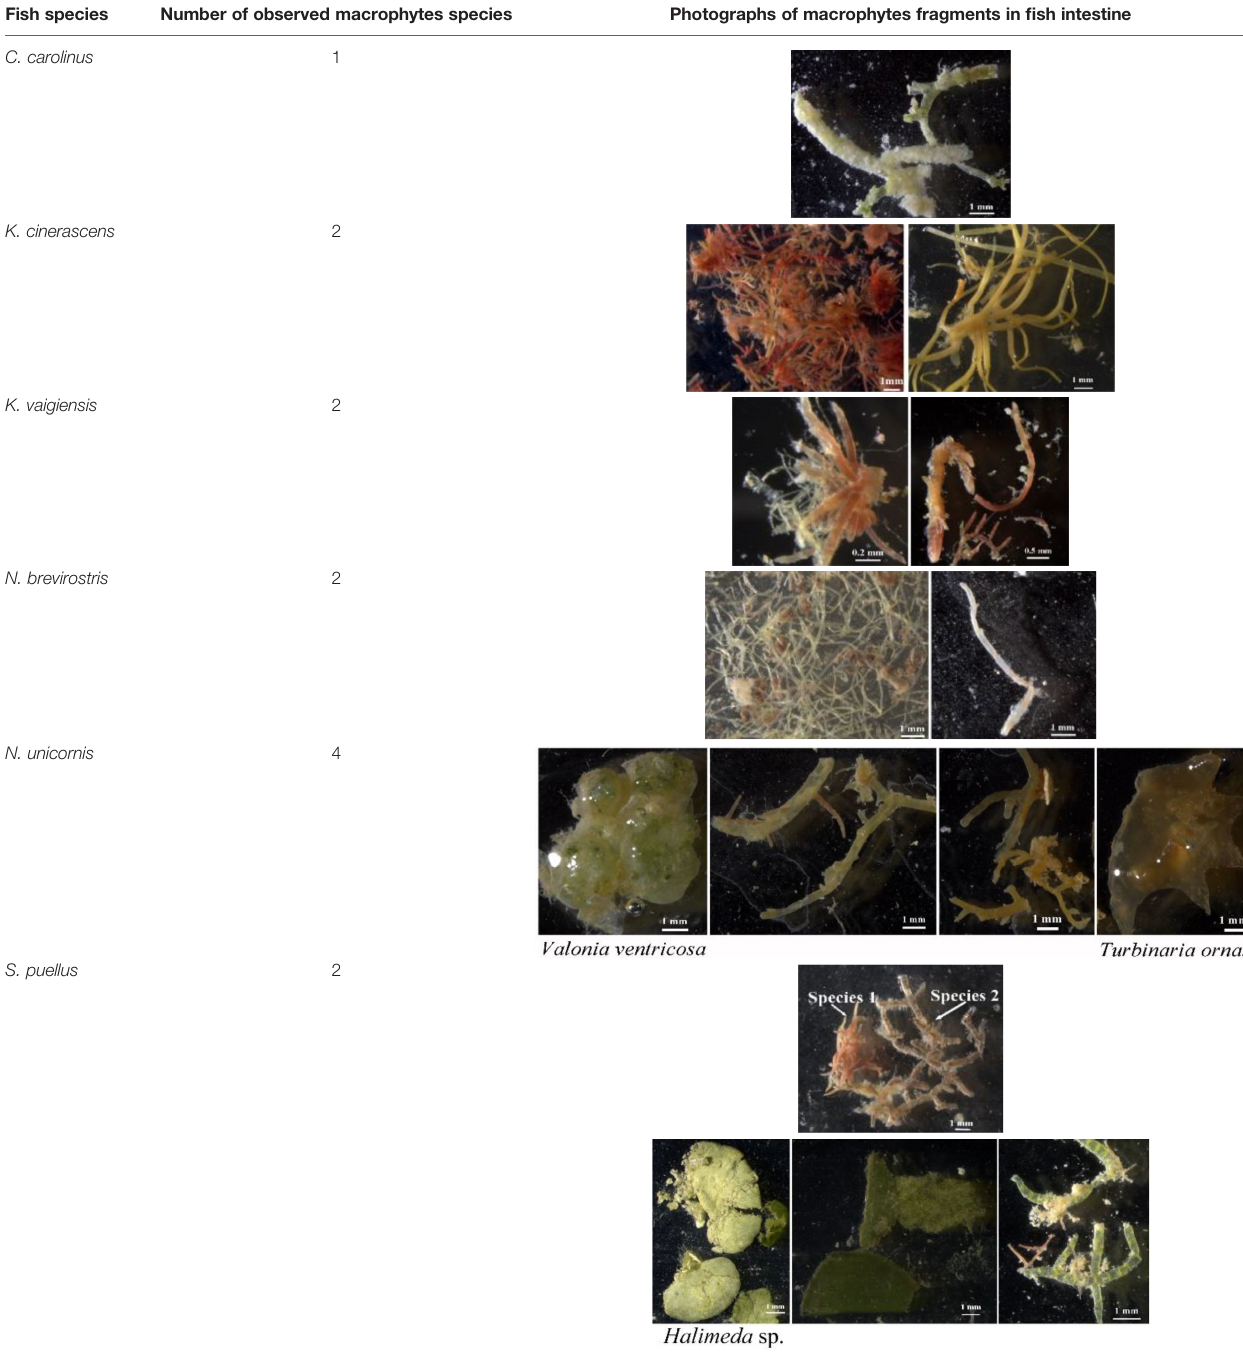
TABLE 2 | Macrophyte fragments observed by microscopic examination in the intestinal contents of fi shes from the Xisha coral reefs. Fish species Number of observed macrophytes